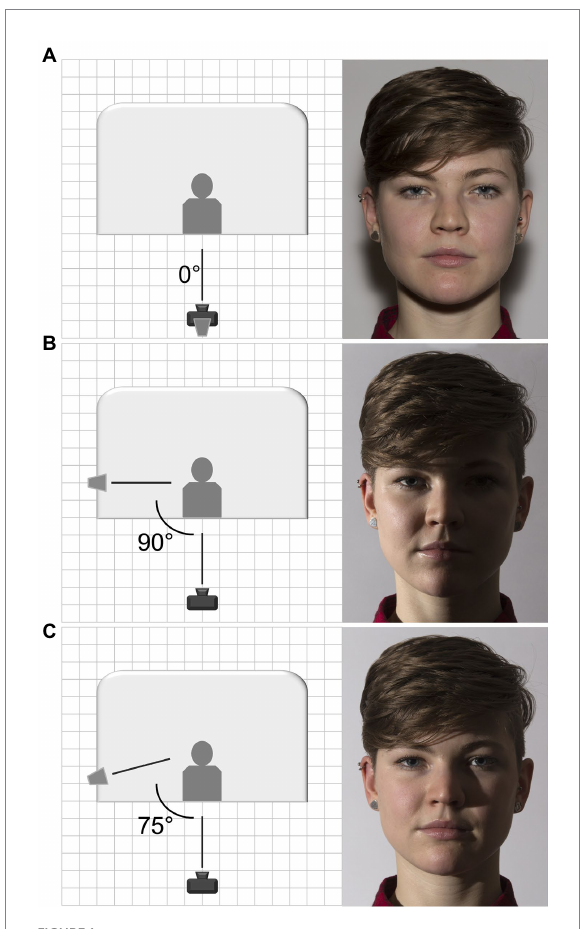
FIGURE 1 Photograph setting and example of one image for the flat (A) , split (B) , and Rembrandt (C) lighting